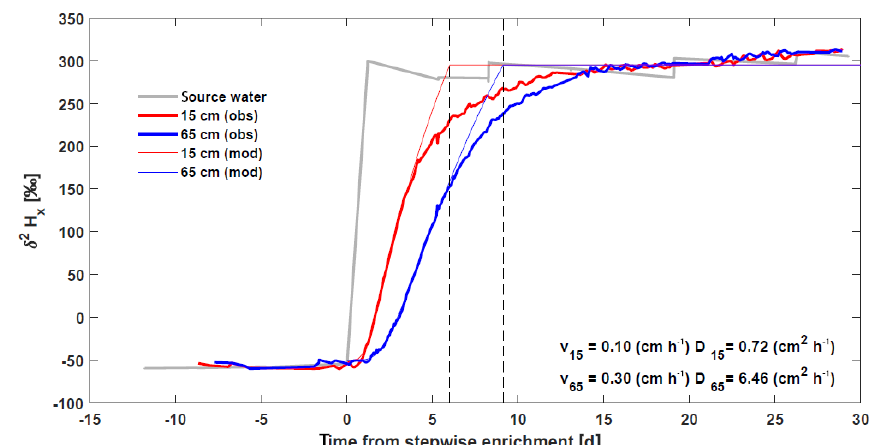
Figure 6. Basic model validation comparing continuous in situ δ 2 H X measurements of a stepwise 2 H enrichment experiment (Marshall et al., 2020) with analytical solutions of an advection–diffusion equation at heights 0.15m ( ) and 0.65m ( ) on a pine tree ( Pinus pinea L.). The source water of the intact-root, isotopic-enrichment greenhouse experiment is presented in gray. Model parameters, velocity, and diffusion were fitted by visual inspection independently for the two heights to match the initial increase in isotope signature (values reported in the bottom